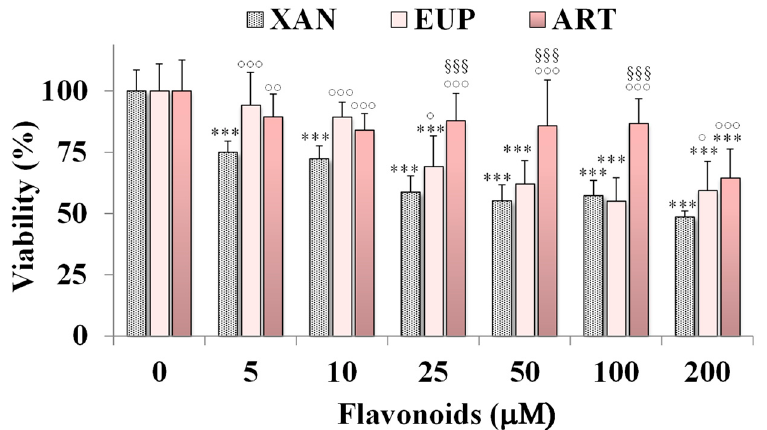
Figure 2. Viability, expressed as % of the control (0), induced by incubation for 24 h with different amounts (5–200 µ M) of xanthomicrol (XAN), eupatilin (EUP), and artemetin (ART) in cancer HeLa cells (MTT assay). Three independent experiments are performed, and data are presented as mean and SD ( n = 15). For each series: *** = p < 0.001 versus Ctrl. For each concentration group: °°° = p < 0.001, °° = p < 0.01, ° = p < 0.05 versus XAN-treated cells; §§§ = p < 0.001 versus EUP-treated cells. Statistical significance of differences was assessed by One-way ANOVA and Bonferroni post Test.